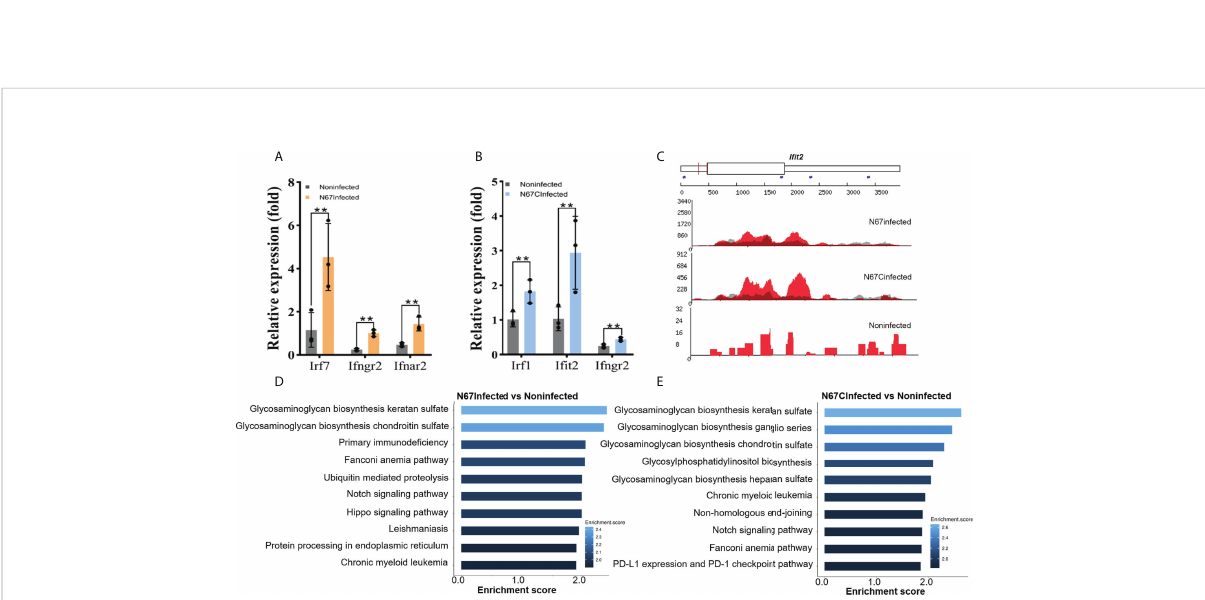
FIGURE 4 Malaria parasite infection-induced m 6 A modi fi cations reprogram host immune response pathways. (A) Transcript expression of interferon stimulated genes from N67Infected and noninfected spleens, respectively. (B) Transcript expression of interferon stimulated genes from N67CInfected and noninfected spleens, respectively. Values are the means±SD, n =3. ** P < 0.01, Student ’ s t test. (C) Integrative genomics viewer (IGV) plots of m 6 A-IP (red) and Input (grey) showing m 6 A peaks of I fi t2 in N67-, N67C-infected or noninfected spleens. The Y axis represents the normalized m 6 A signal along the gene. (D) Biological processes of differentially expressed genes with m 6 A peaks in N67-infected mice spleens compared to noninfected mice spleens. (E) Biological processes of differentially expressed genes with m 6 A peaks in N67C- infected mice spleens compared to noninfected mice